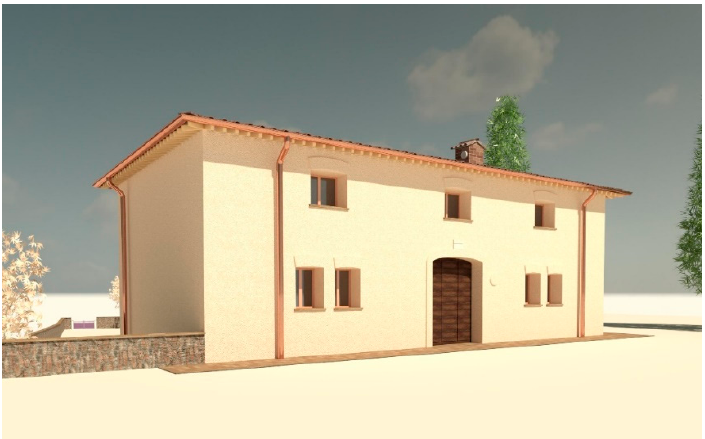
Figure 3. 3D view of the architectural model. Energies 2020 , 13 , x FOR PEER REVIEW